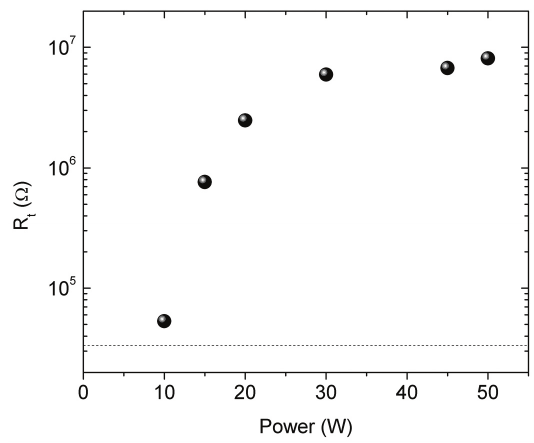
Figure 16. Total resistance as a functions of the plasma deposition power for the films deposited from HMDSO/O Dashed line corresponds to the total resistance for the uncoated polished alloy.